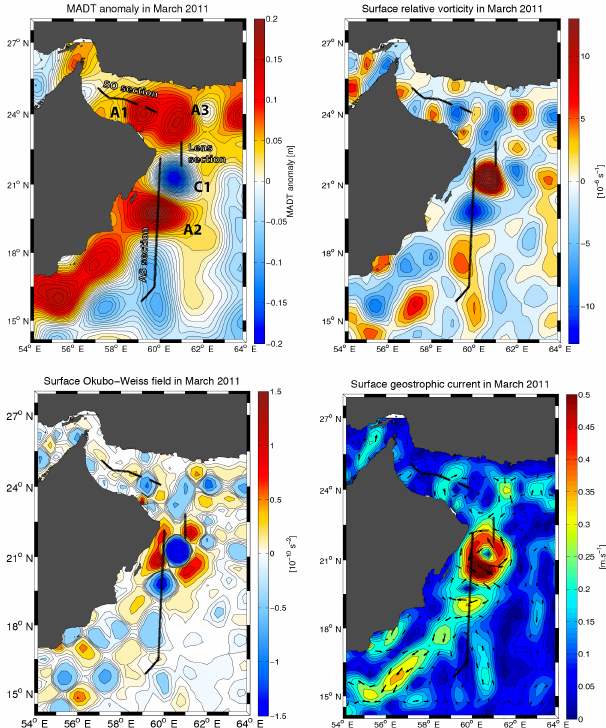
Figure 4. Maps of the surface fields averaged from 16 to 30 March 2011, during the measurements south of Ra’s Al Hadd (AS sec- tion), in the lens off Ra’s Al Hadd (lens section), and across the Sea of Oman (SO section). Fields are ADT anomaly (top, left), rela- tive vorticity (top, right), Okubo–Weiss criterion (bottom, left), and geostrophic velocity (bottom,